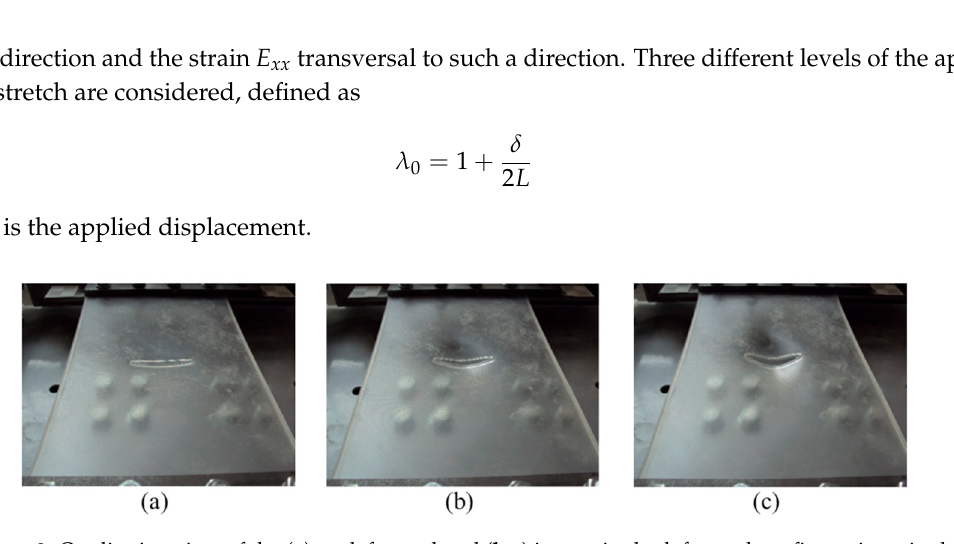
Figure 3. Qualitative view of the ( a ) undeformed and ( b , c ) increasingly deformed configurations, in the flawed specimen El1.